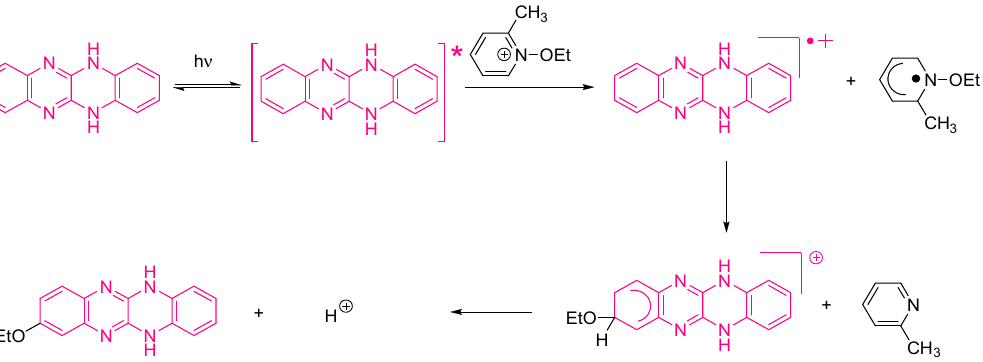
Scheme 4. Mechanism of photobleaching occurring with the fluoflavin dyes/alkoxypyridinium salts combinations.